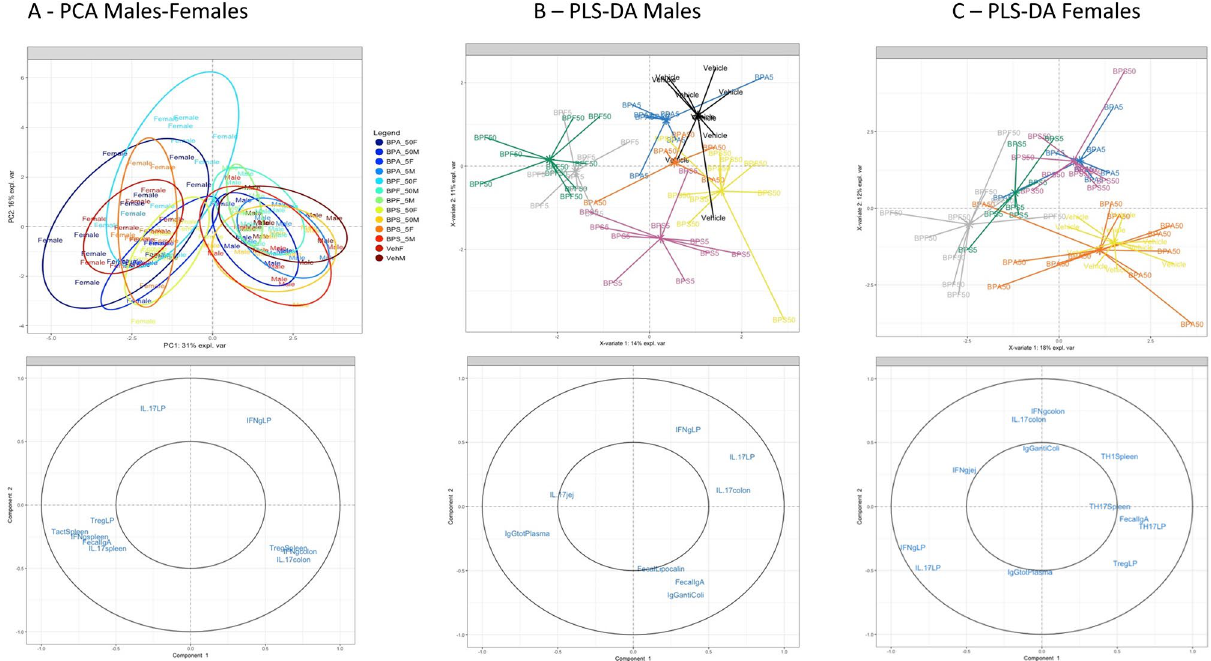
Figure 6. Multivariate analysis representing immune profiles in function of BP dermal exposure and sex in adult offspring mice. ( A ) Sample score plot and associated loading plot on the first two PCA components resulting from all data set (without BW associated parameters) in males and females offspring mice. Each color indicated groups for each sex with 0.85% confidence level ellipse plots. ( B ) PLS-DA sample score plot and associated loading plot on the first two components derived from data set from all treated groups in male offspring mice (without BW associated parameters). ( C ) PLS-DA score plot and associated loading plot on the first two components derived from data set from all treated groups in female offspring mice (without BW associated parameters). Only loadings with correlation threshold > 0.5 were represented on the loading plots. % expl var: percentages for each first two components explained by the model . N = 5–12 offspring mice per